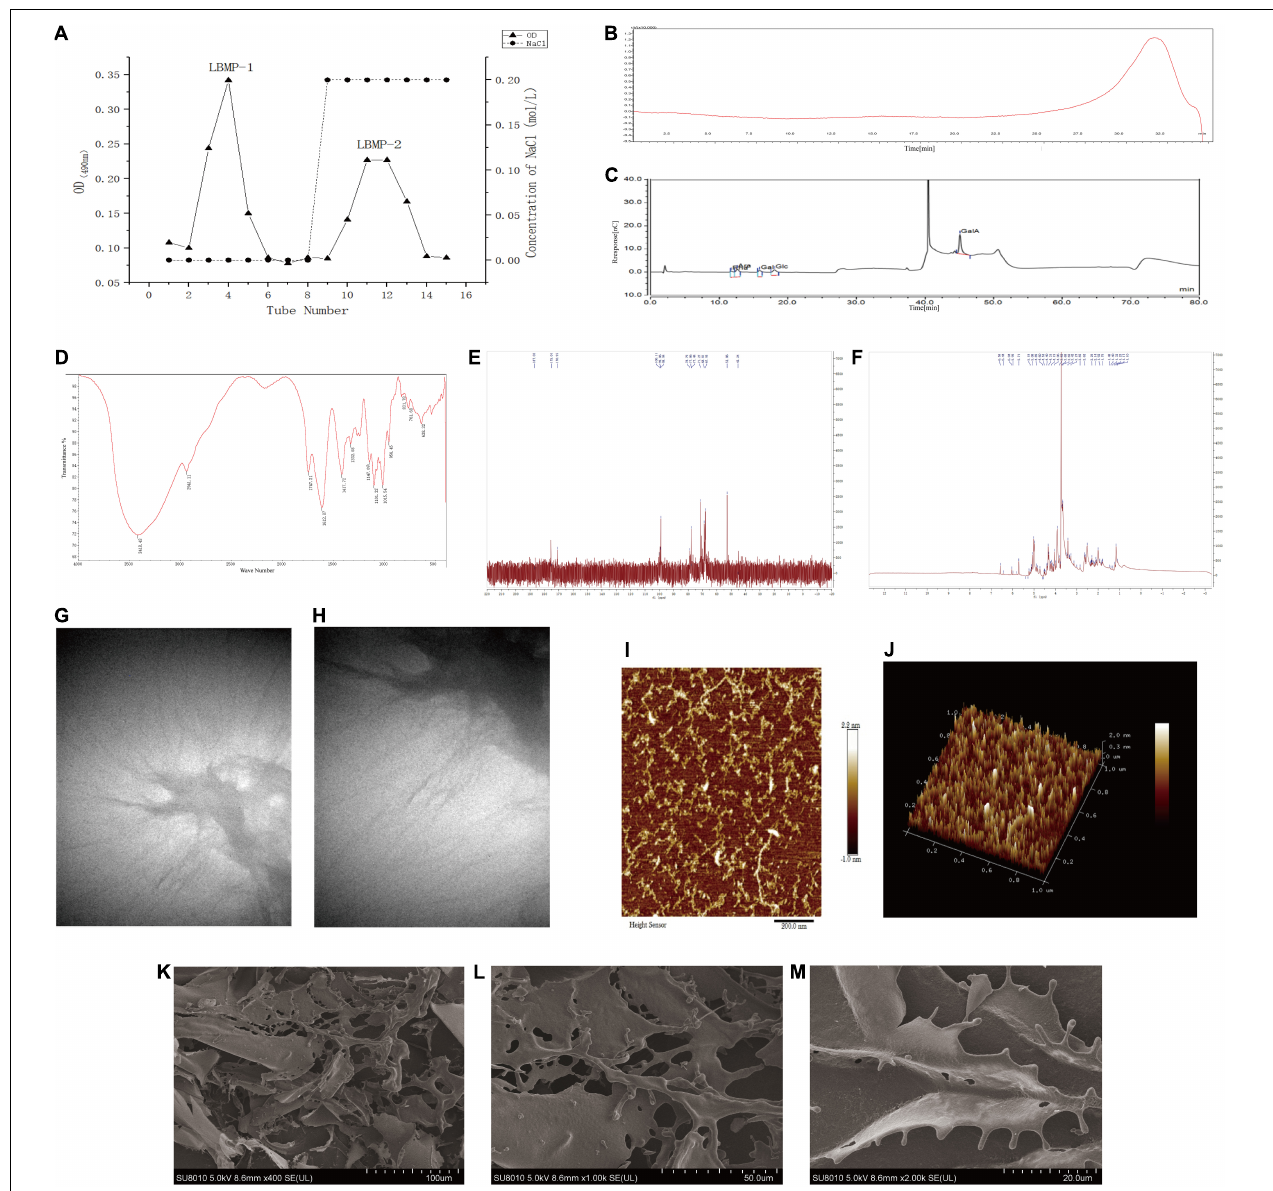
FIGURE 1 | Characterization of LBMP-2. (A) Isolation and purification of LBMP-2. (B) HPGPC of LBMP-2. (C) IC of LBMP-2. (D) FT-IR spectra of LBMP-2. (E,F) NMR spectra of LBMP-2. (G–M) Microstructure analyses of LBMP-2.